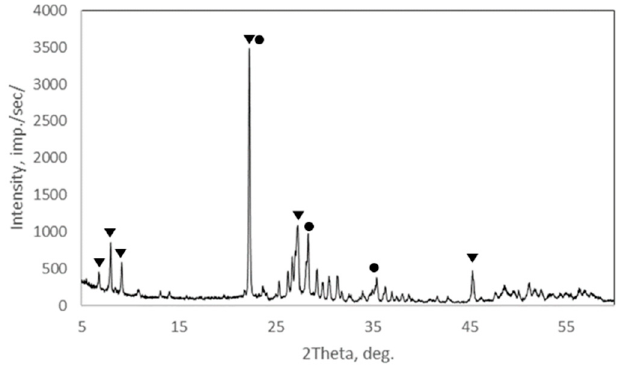
Figure 1. X-ray diffractogram of the Mo-V-Te-Nb catalyst. —characteristic reflexes of the ortho- rhombic phase M1; —characteristic peaks of the hexagonal phase (M2).